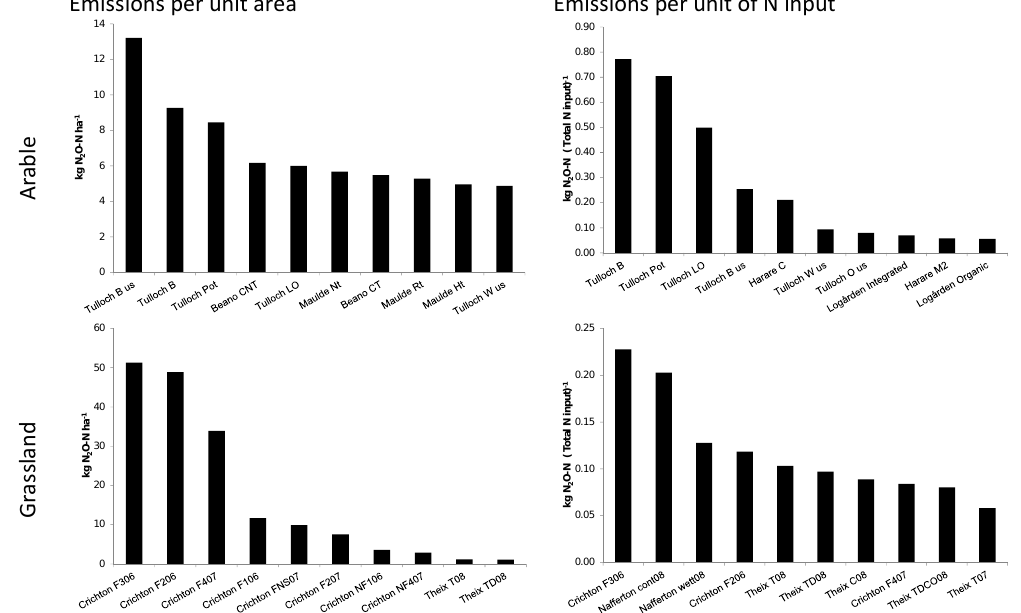
Fig. 4. Ranking of annual emissions data from individual arable plots. The top 10 sites are ranked on emissions per unit area (kgN 2 O-Nha − 1 ) and per unit of N 2 O per unit of N total input (synthetic fertiliser, manure and biological N fixation (kgN 2 O-NkgNinput − 1 ). See Table 3 for a description of the treatment codes.